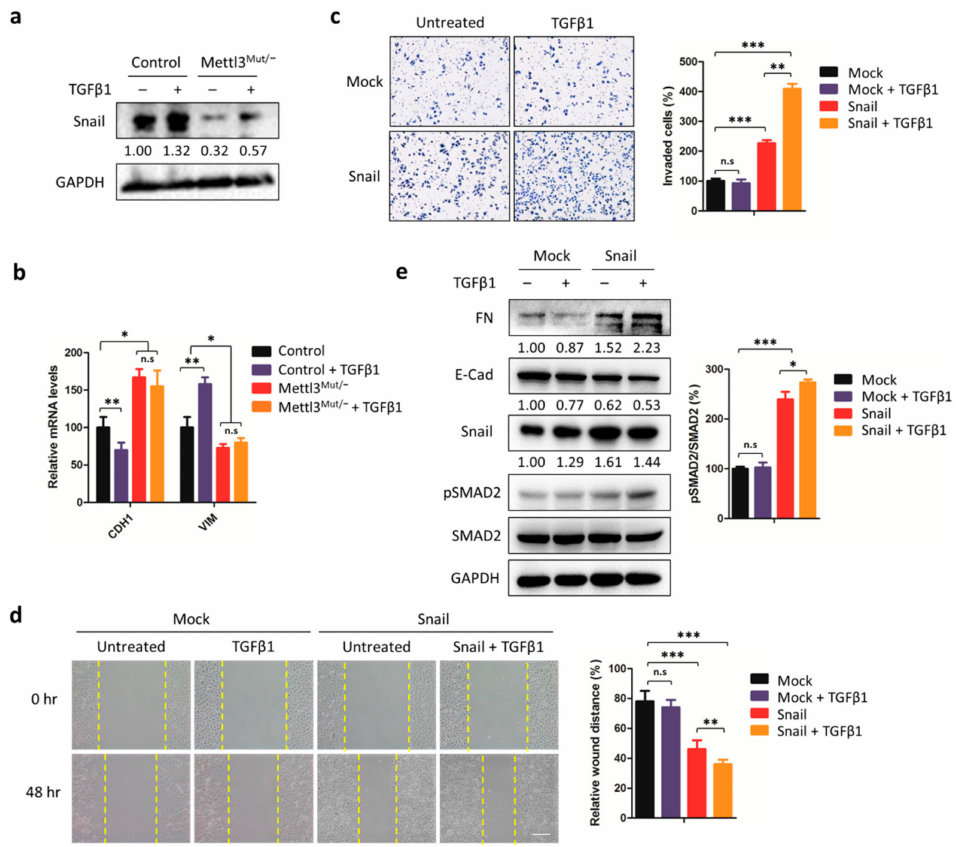
Figure 6. Snail is the core protein responsible for METTL3-mediated EMT. ( a ) Control and Mettl3 Mut / −